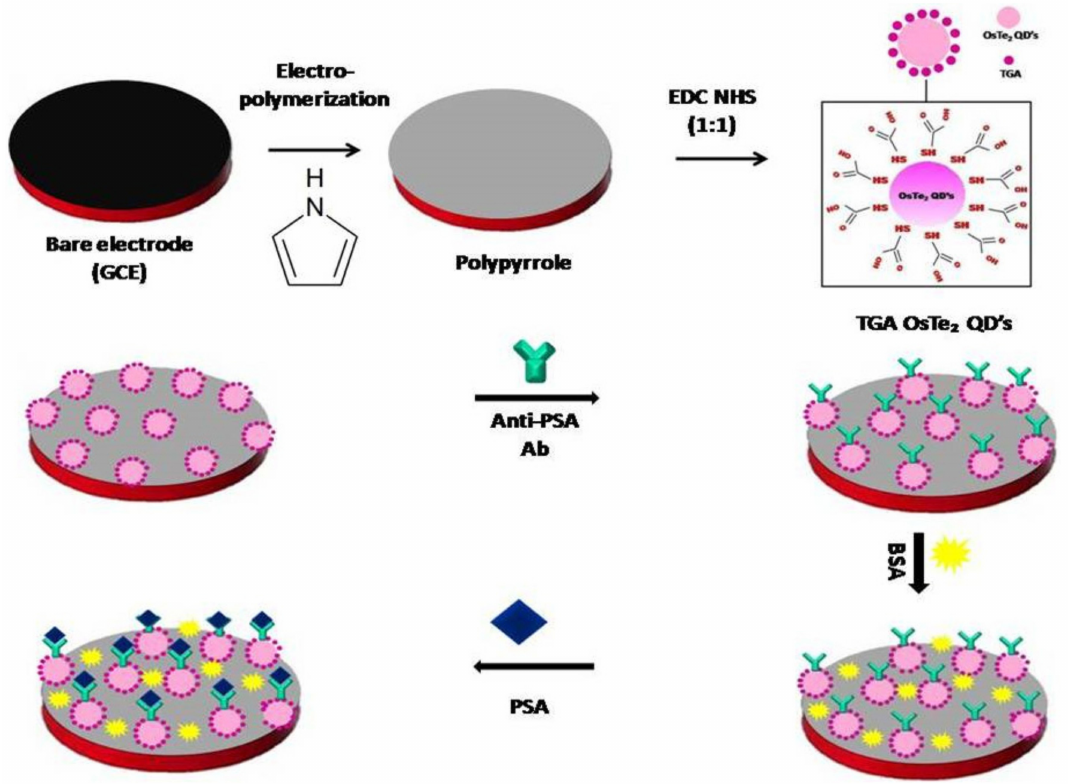
Figure 1. Schematic representation of electrochemical